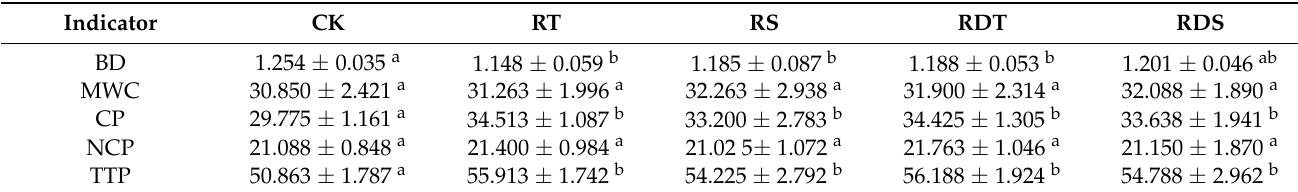
Table 3. Soil physical properties of different residue treatment methods.